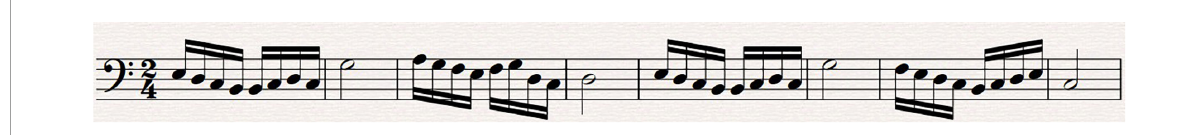
FIGURE1 20-Second piano melody written for this study. © 2022 IEEE. Reprinted with permission from Cai and Zhou (2021).